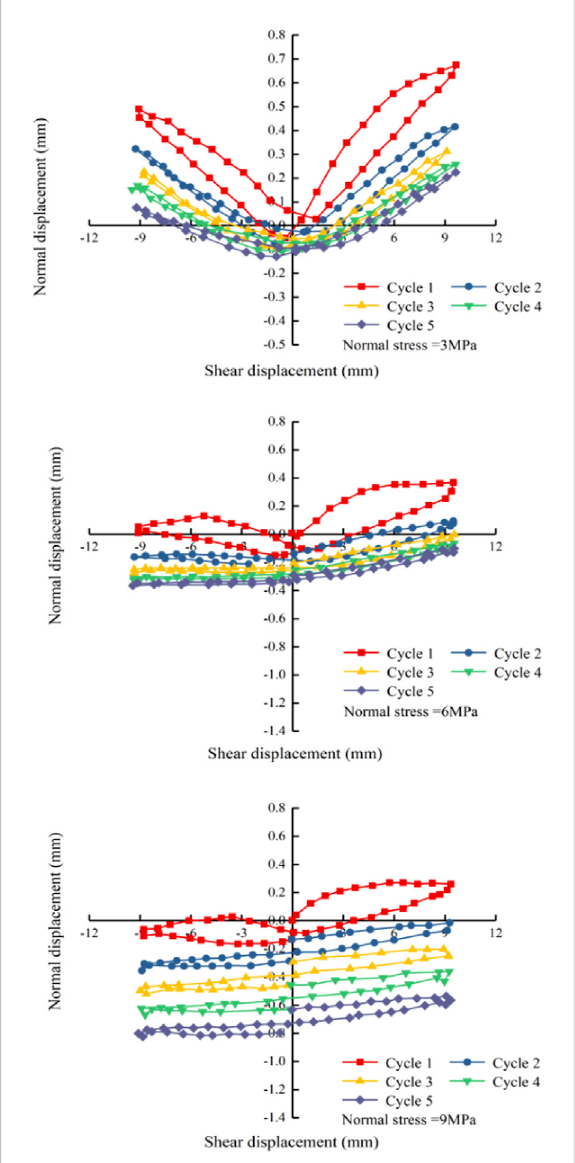
FIGURE 5 Normal displacement-shear displacement curve of the structural plane under different normal stresses (Qu 2018; Dong et al.,